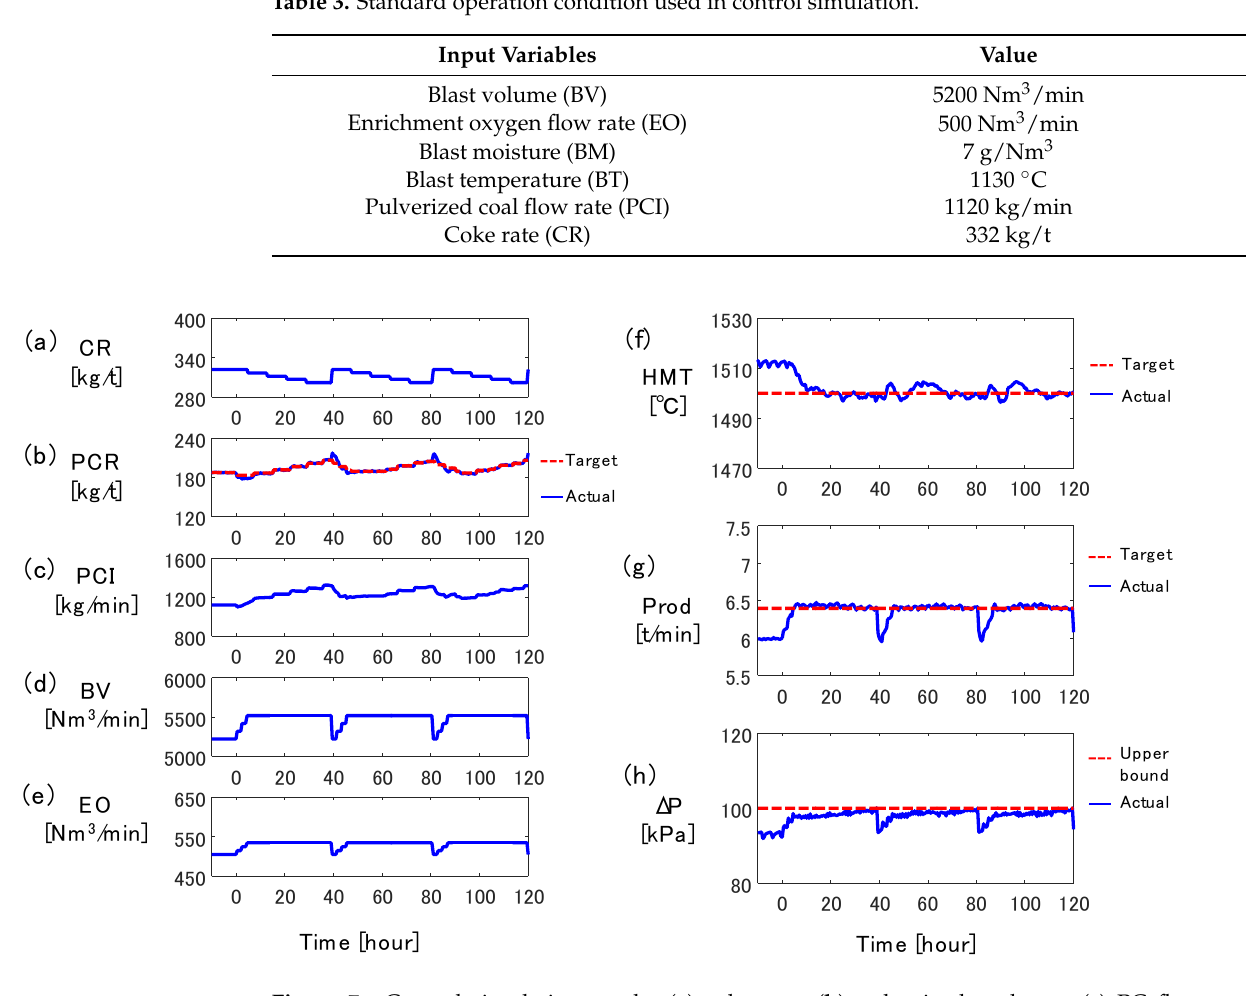
Figure 6. Flowchart of control simulation.